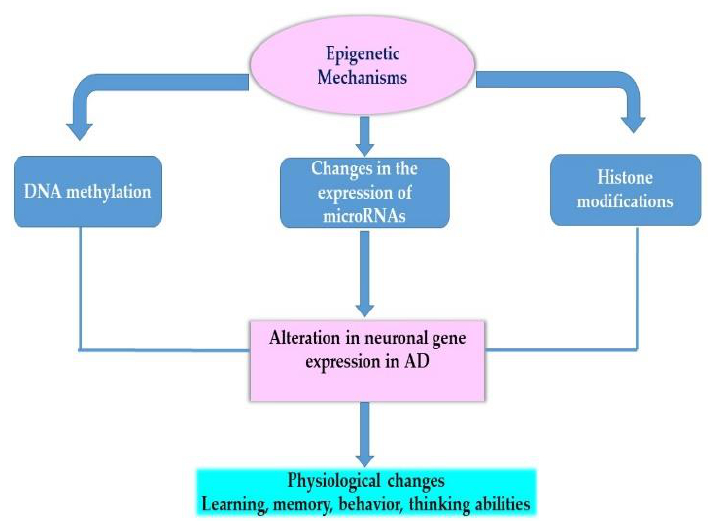
Figure 3. The role of epigenetic mechanisms in modulation of gene expression. This figure provides an overview of the role of epigenetic mechanisms in modulation of the genome and the consequences of such modulation on phenotype. These mechanisms include DNA methylation of genes, changes in specific histone marks along genes or changes in the expression of genes by specific microRNAs. How are these epigenetic mechanisms linked to the pathology of AD and how can we use that knowledge in AD-related research and apply it clinically? AD neuropathology shows complex genetic and epigenetic components and complex interactions between the two factors suggesting that this neurodegenerative disease is impacted by environ- mental factors and shows global or gene-specific epigenetic alterations in neurons